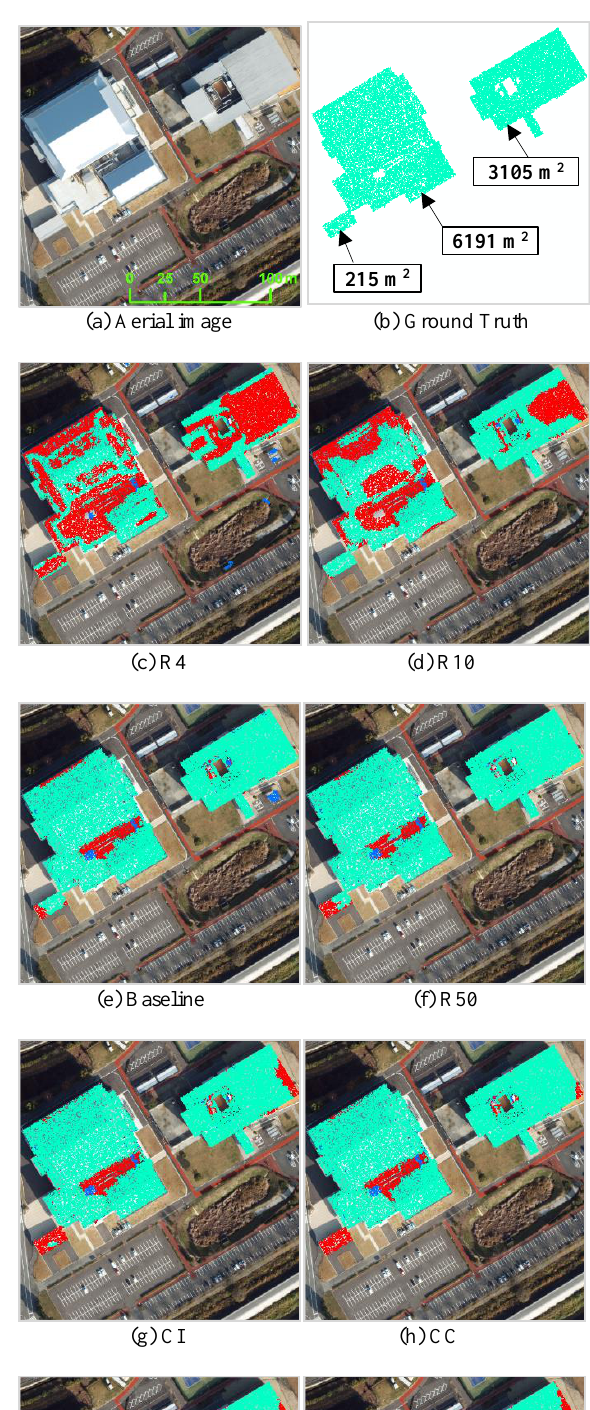
Figure 11 . Examples of building detection. TP, TP; FN, FN (misdetections); FP, FP (over-detections)